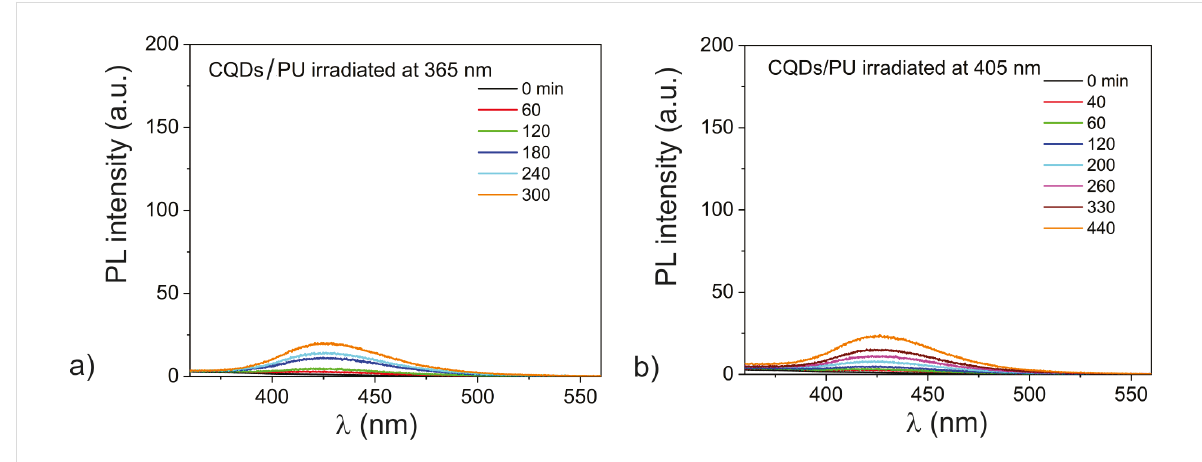
Figure 4: (a) PL spectra of h-TA at different times under 365 nm excitation with 6 mW/cm 2 intensity; (b) PL spectra of h-TA at different times under 405 nm excitation with 40 mW/cm 2